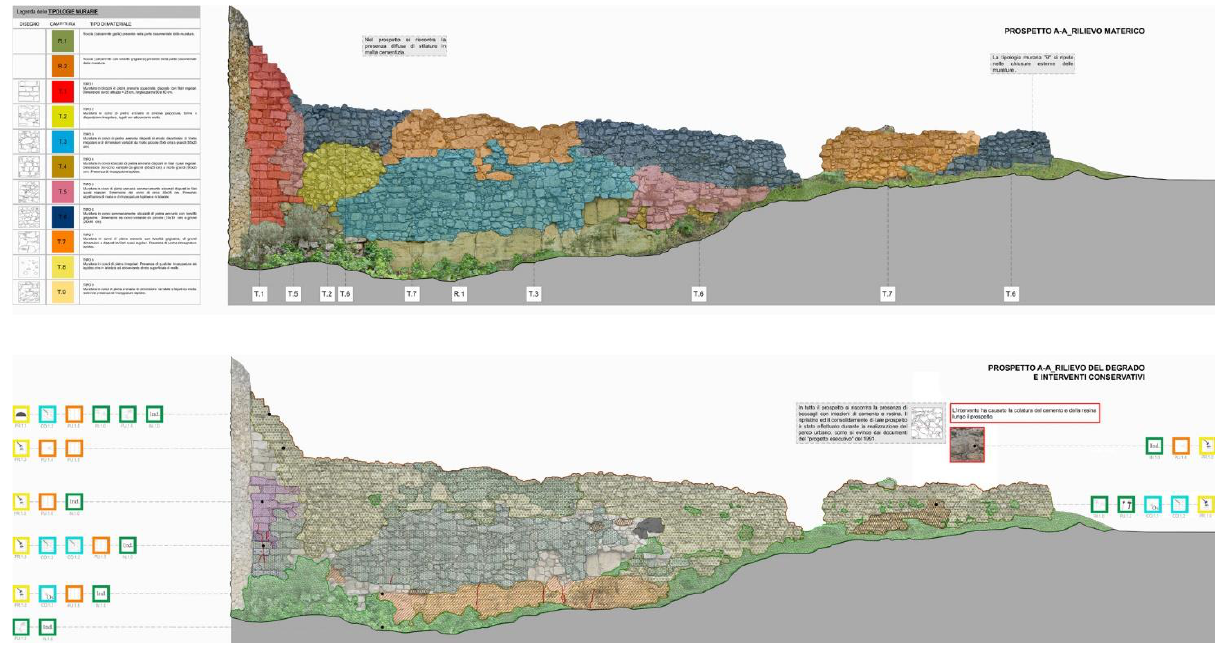
Figure 5. The wall masonry characterisation, the decay mapping and the conservation